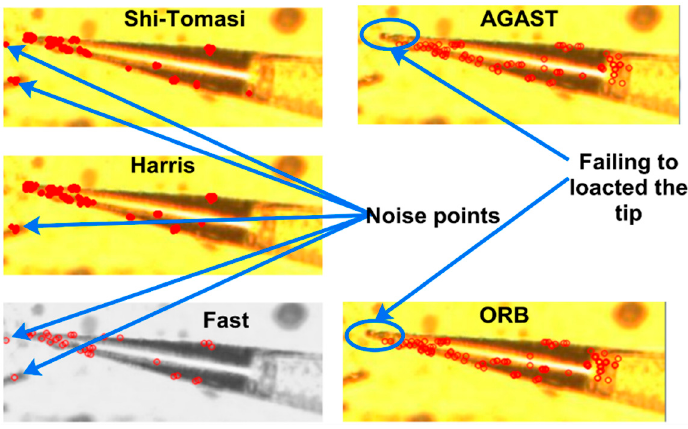
Figure 23. Corner detection using different methods.